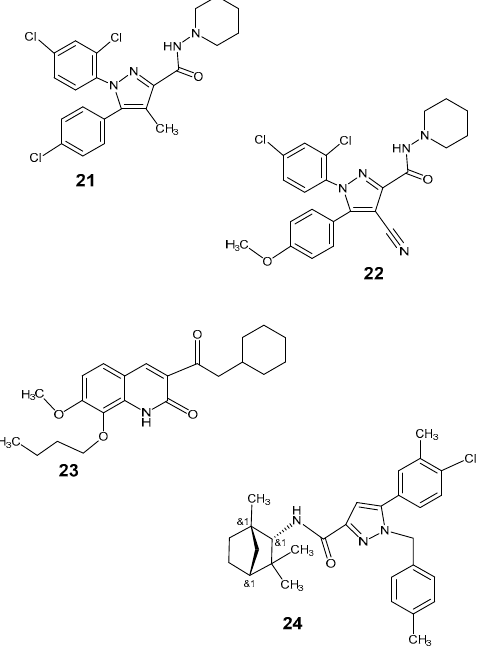
Figure 5. Cannabinoid receptor ligands. CB1: 21 SR141716 (Rimonabant); 22 [ 11 C] JHU-75528; CB2: 23 NE40; 24 SR144528 (CB2).